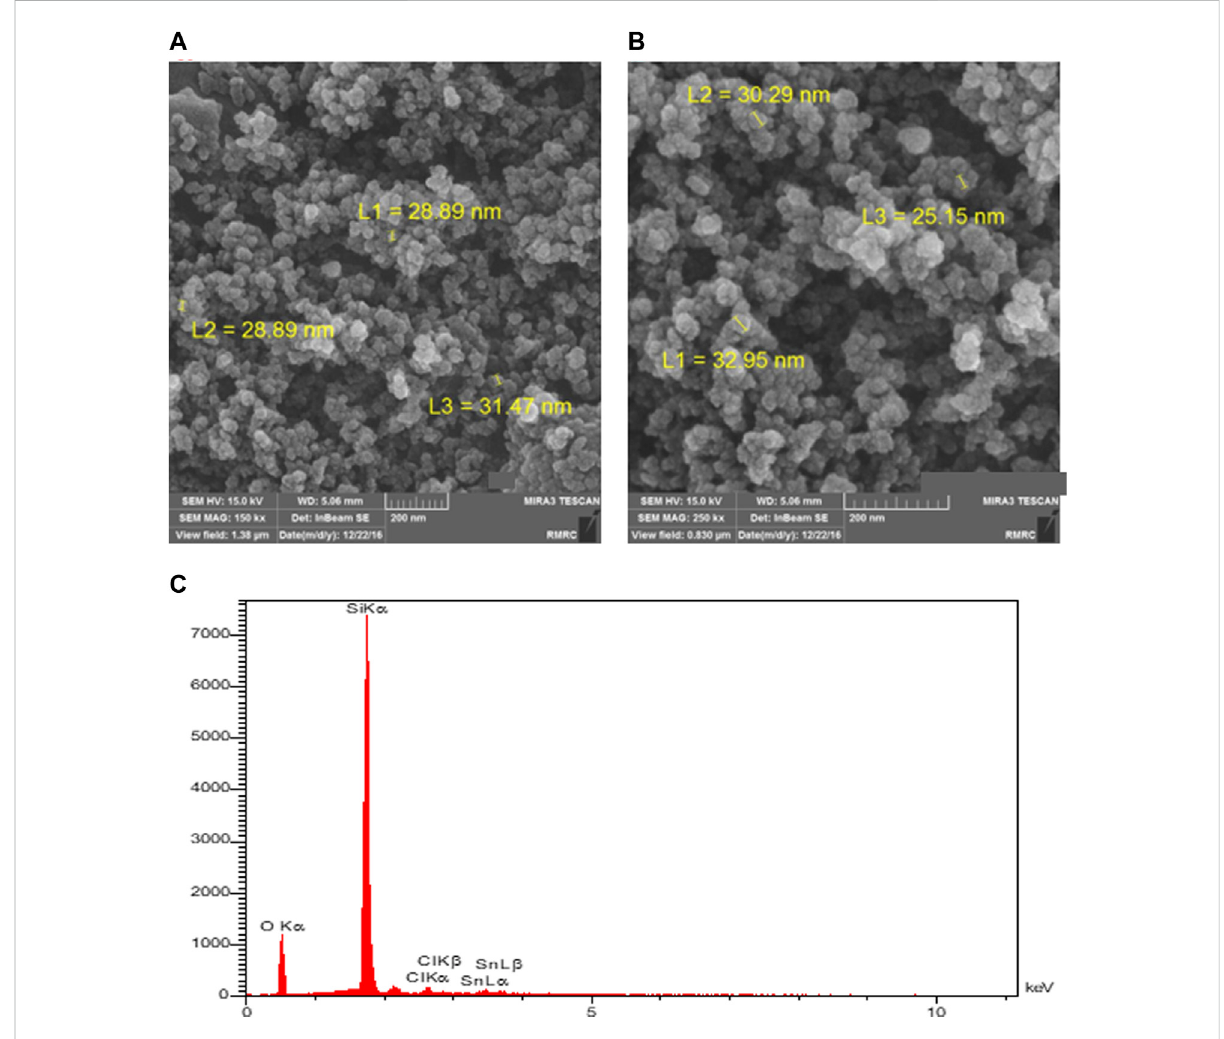
FIGURE 2 FESEM images of the prepared (A) and used (B) catalyst (after fi ve runs) and the EDS analysis of the prepared catalyst (C)